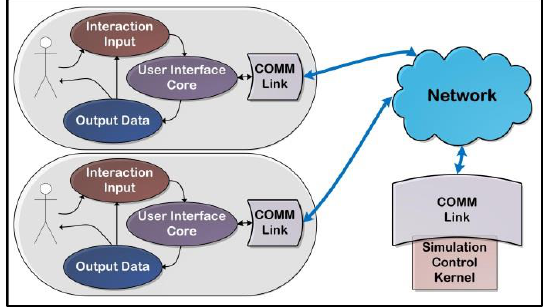
Fig. 16. System with multiple interfaces accessing a